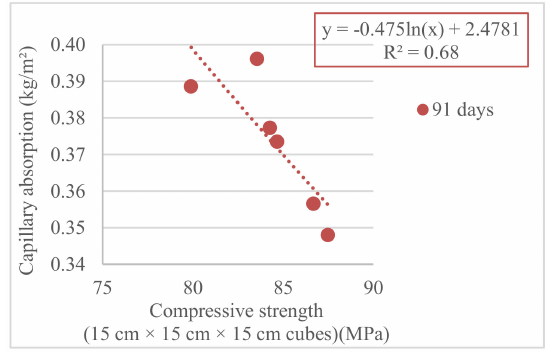
Figure 7. Relationship between capillary water absorption and compressive strength (15 cm × 15 cm × 15 cm cubes) results at 91 days.